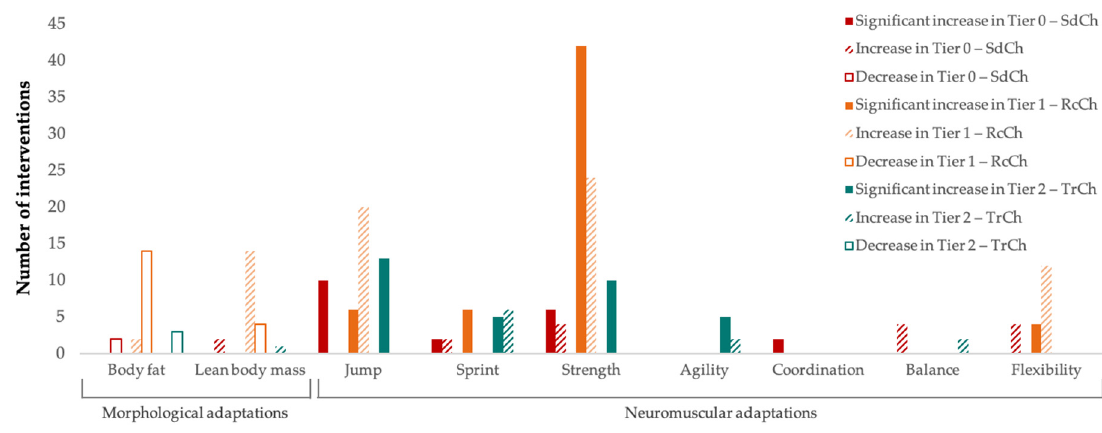
Figure 3. Neuromuscular and morphological adaptations from STPs according to PAL.